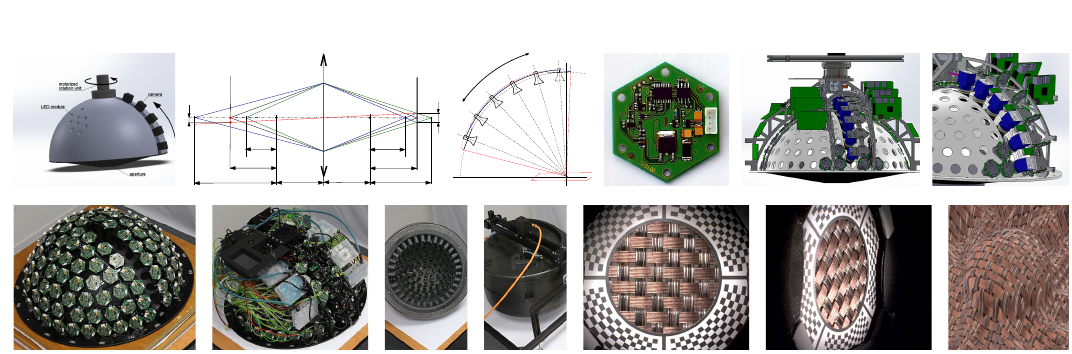
Figure 1. We propose a compact portable lightdrum for bidirectional texture function (BTF) and bidirectional reflectance distribution function (BRDF) measurements on site that uses the principle of a rotating light stage. It is suitable for real life application scenarios, including predictive rendering in cinema, design industry, etc. The project pipeline is shown, starting with our device concept to its design, construction, assembly, through measurement of a sample and finishing with a rendered 3D object covered by the measured material